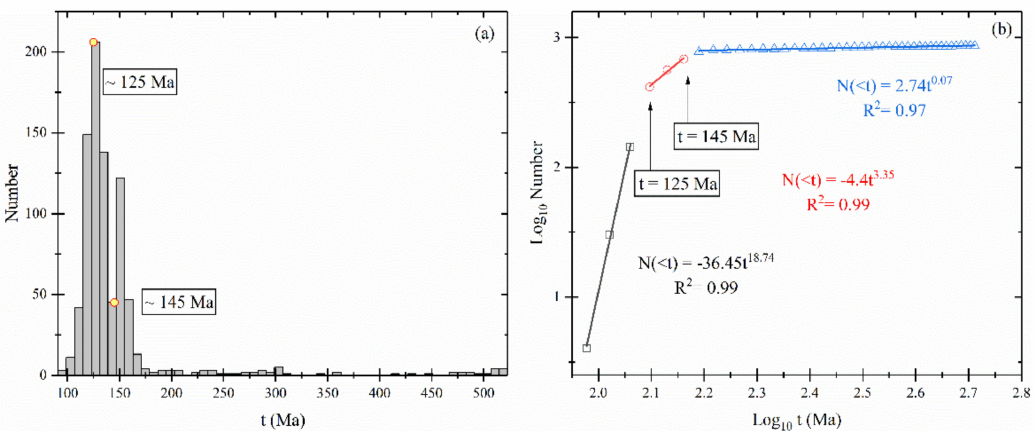
Figure 2. Statistical results of volcanic rock ages in the Great Xing’an Range (GXR). ( a ) The histogram of volcanic rock ages in the GXR; the data were taken from Zhang et al. [4,9], bin = 8 Ma, n = 823. ( b ) The cumulative number-age distribution of volcanic rock ages in the GXR at bin = 10 Ma. Dots represent the cumulative number of ages below the age threshold (t). Three solid lines in di ff erent colors were fitted separated by the least square method for the data from 95 to 125 Ma (black color), between 125 and 145 Ma (red color), and after 145 Ma (blue color) ranging from 145 to 515 Ma. The equations of linear fitting and their coe ffi cients of determination are shown on the graphs.